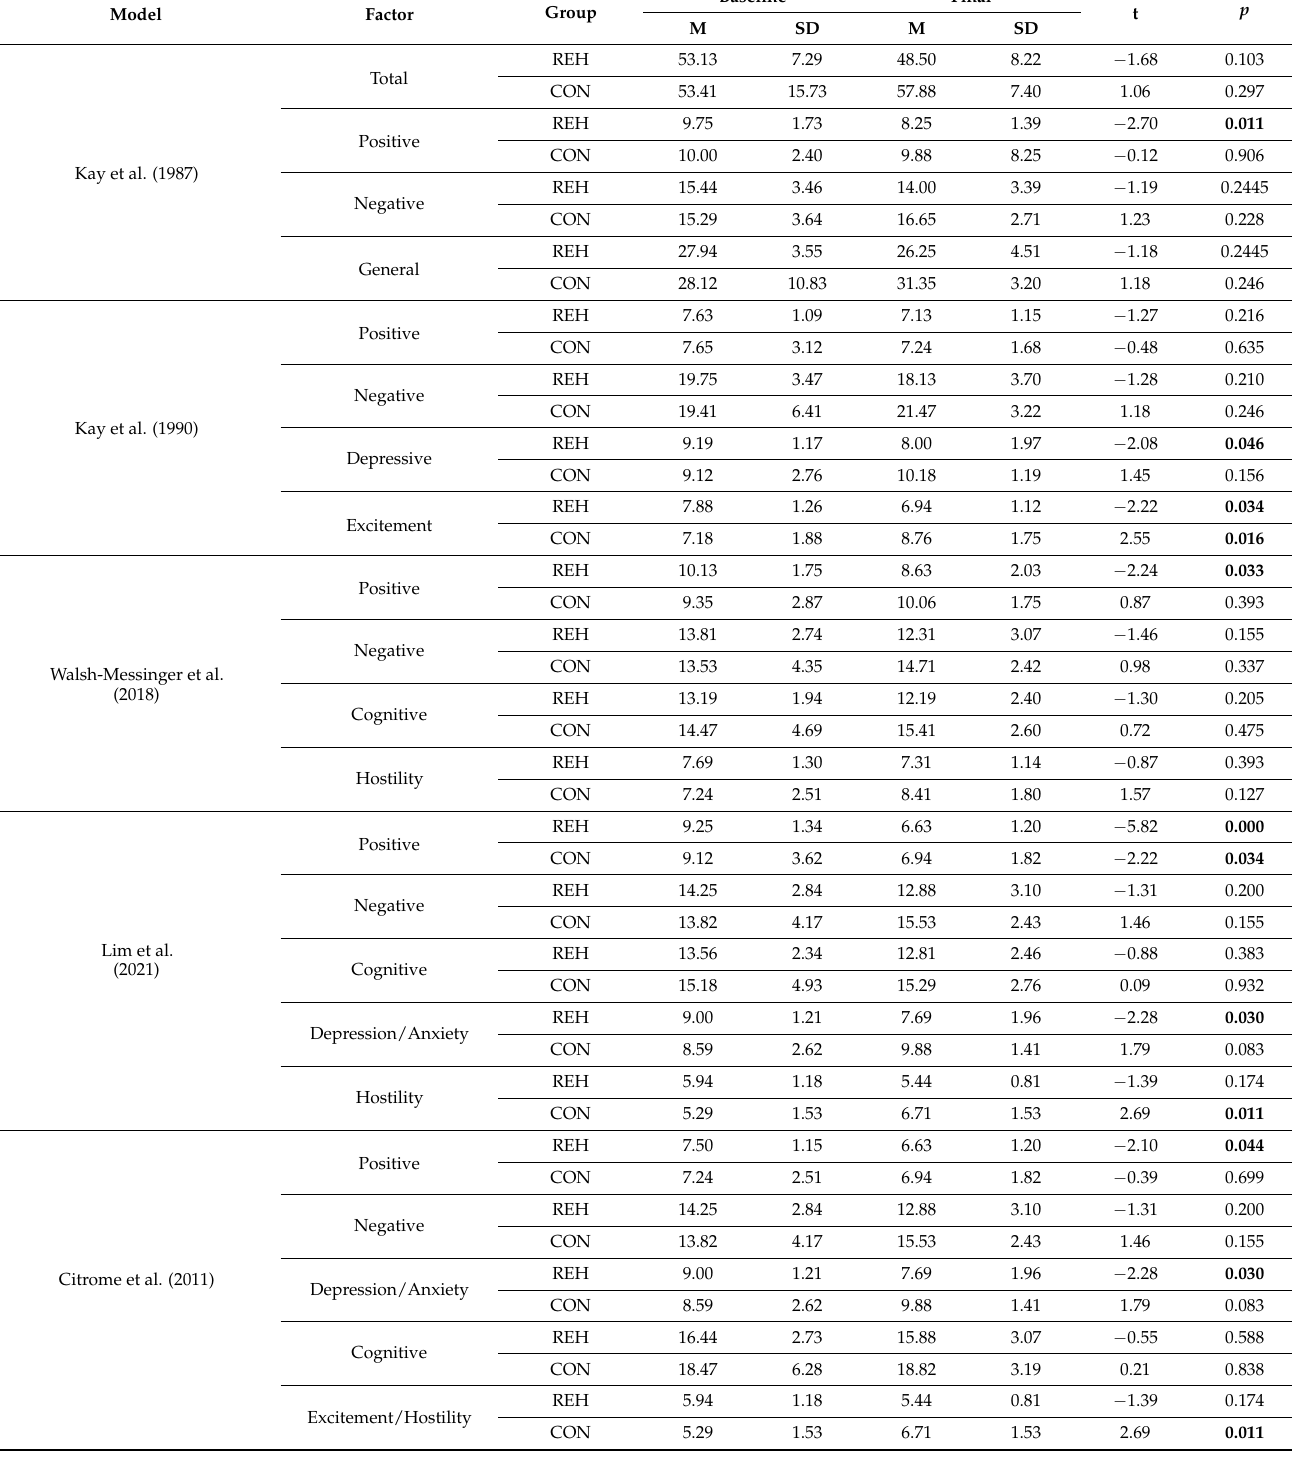
Table 2. T1 versus T2 results: PANSS models and